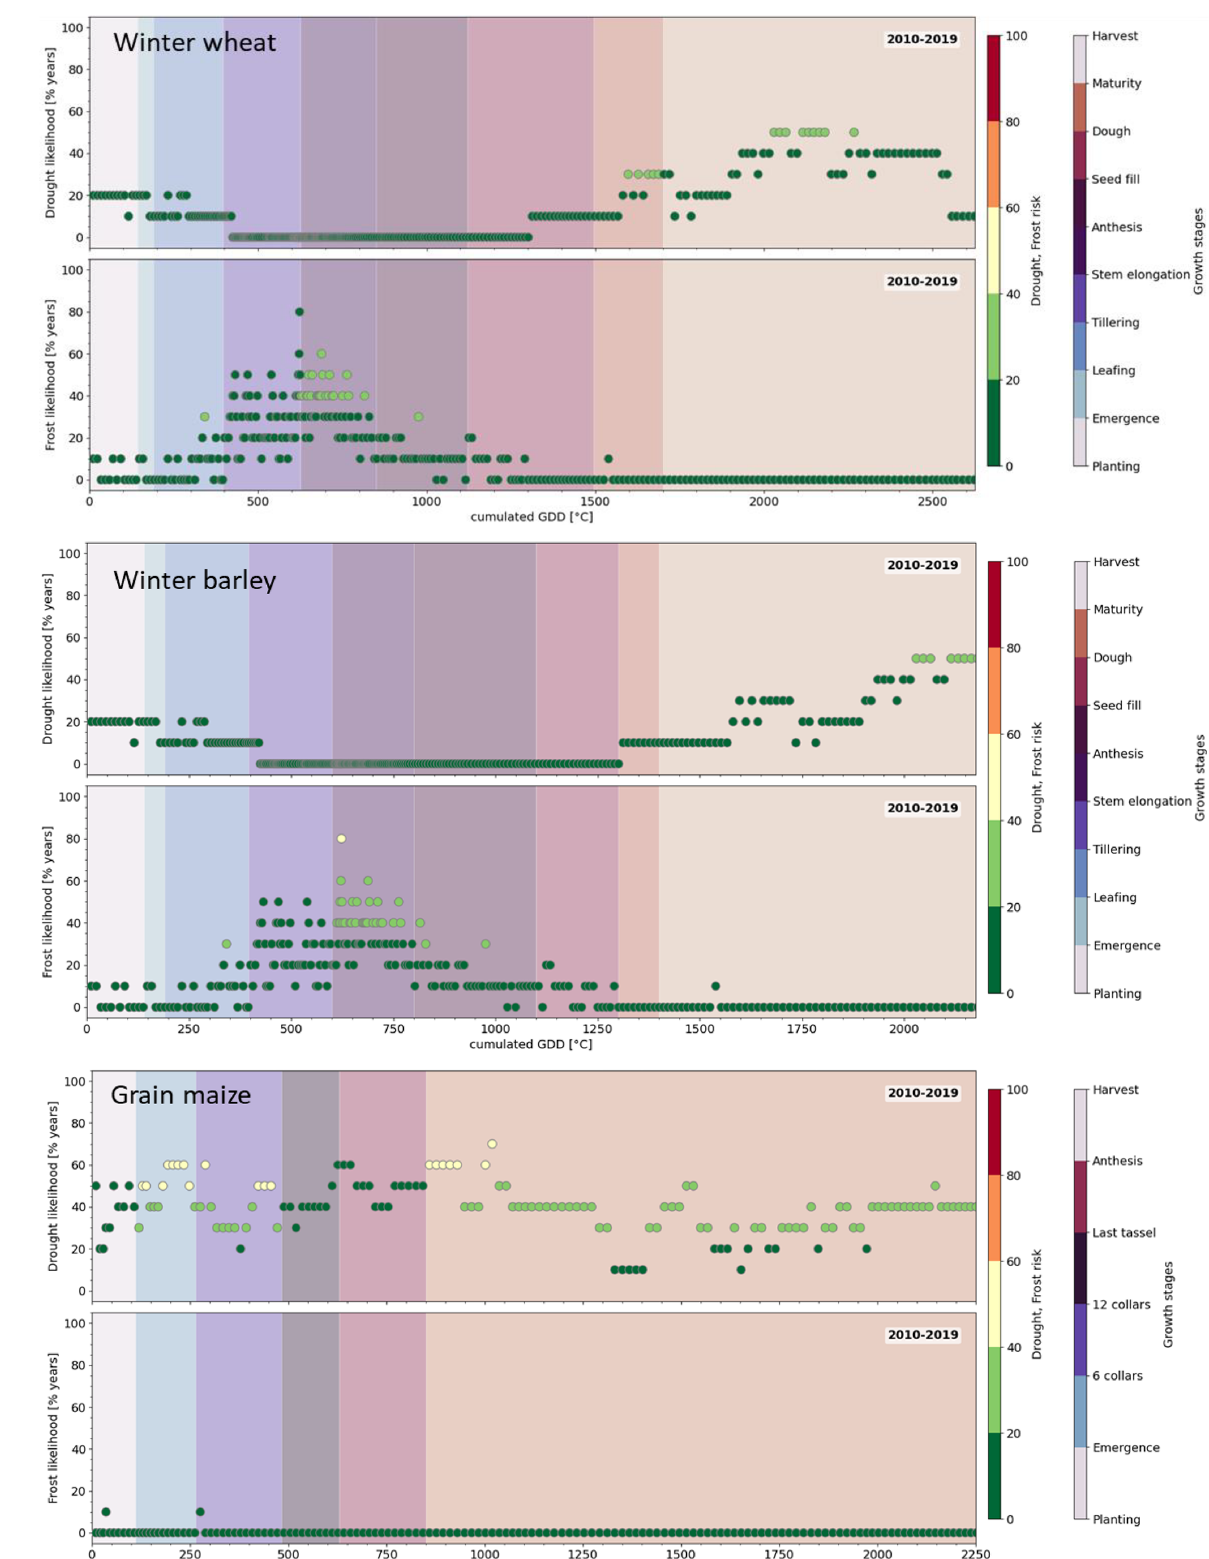
Figure 1. Drought and frost risk for winter wheat, winter barley and grain maize in Belgium,